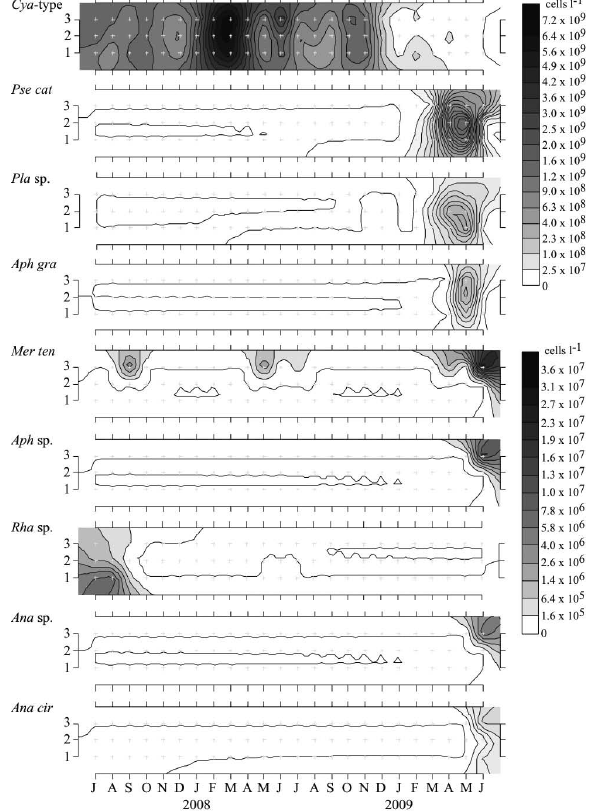
Fig . 7. – Seasonal variations in the abundance of cyanobacterial spe- cies at the three sampling stations of Cabras Lagoon (1, 2, 3) during the investigation period. For abbreviations, see Table